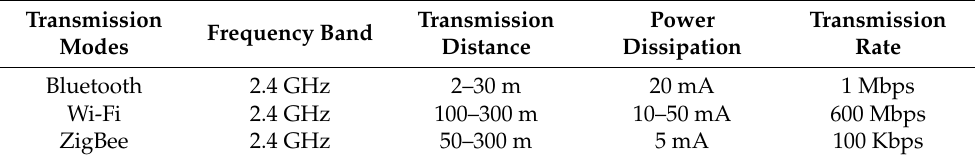
Comparison of three commonly wireless transmission methods (Bluetooth, Wi-Fi, ZigBee) within four parameters (frequency band, transmission distance, power dissipation, transmission